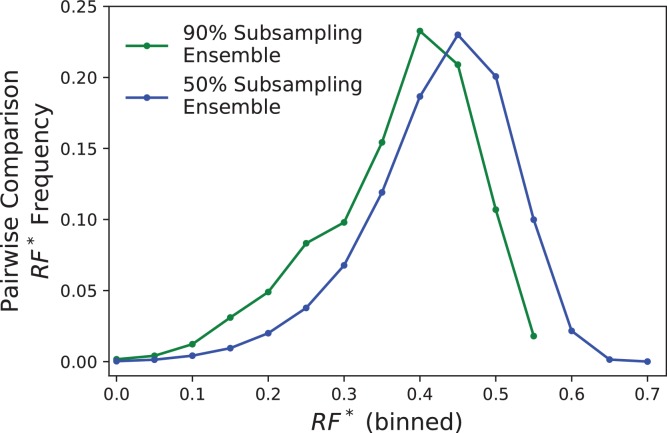
Distributions of pairwise RF∗ differences between LacI topologies in the 90% (green) and 50% (blue) subsampling ensembles.10.7554/eLife.47676.003Figure 1—figure supplement 1—source data 1.Pairwise RF* distributions of LacI topologies.